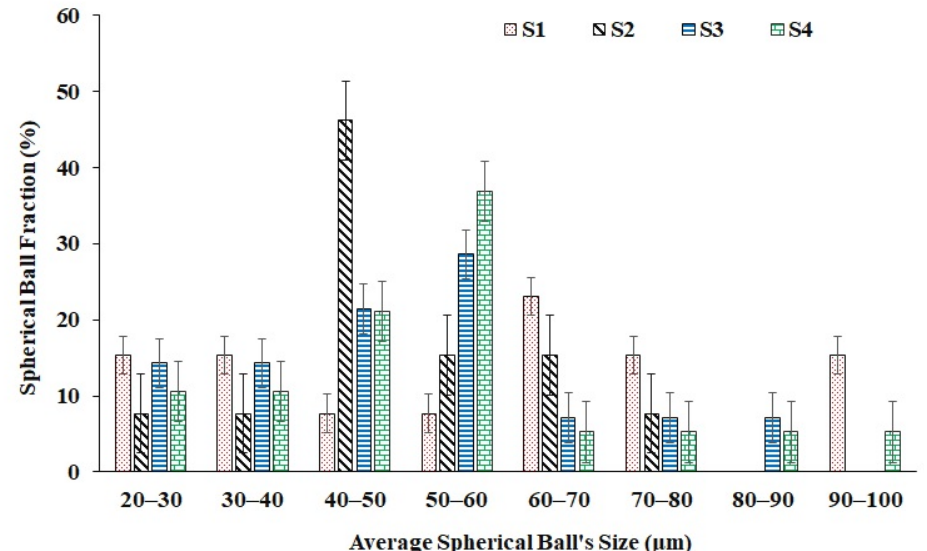
Figure 8. LBPF manufactured samples showed formation of spherical balls. The bar chart shows the distribution of average particle sizes of the spherical balls formed as a function of scan strategy.